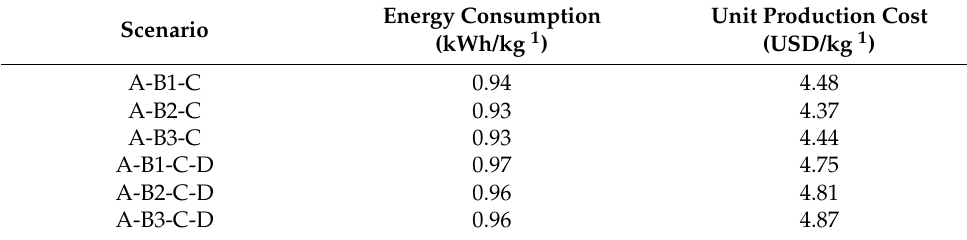
Table 1. Technical information of the base scenarios for the production of biomass of microalgae [15].